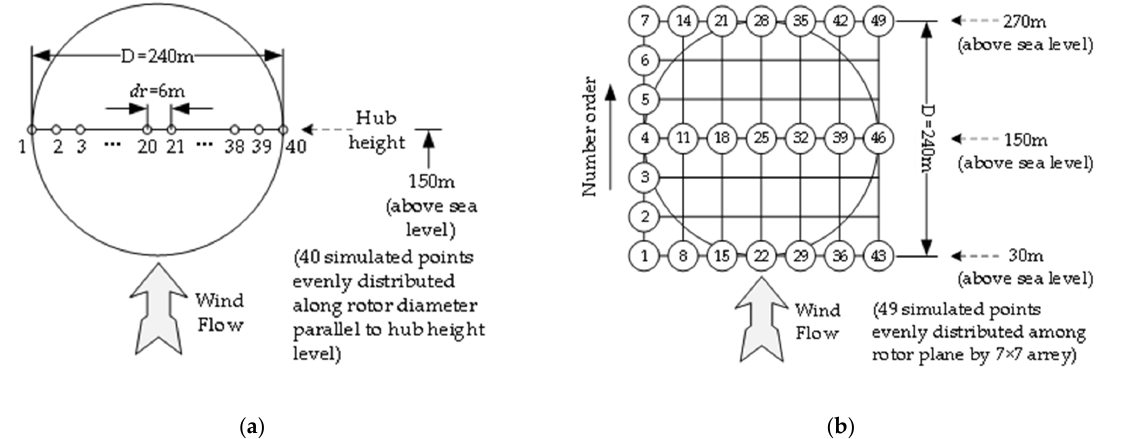
Figure 3. ( a ) The ratio of cut-off standard deviation and defined standard deviation along with the cut-off frequency change curve; ( b ) Standard deviation scatter distribution under different cut-off frequency intervals.